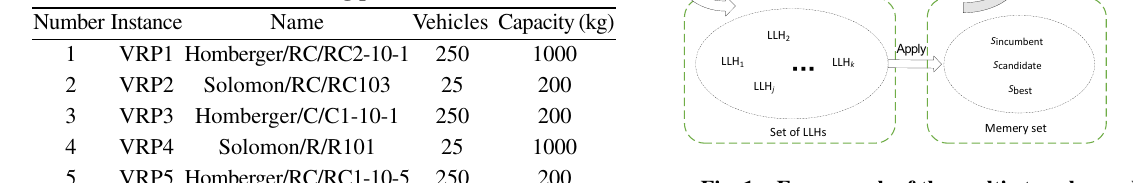
Table 7 Vehicle routing problem instance.